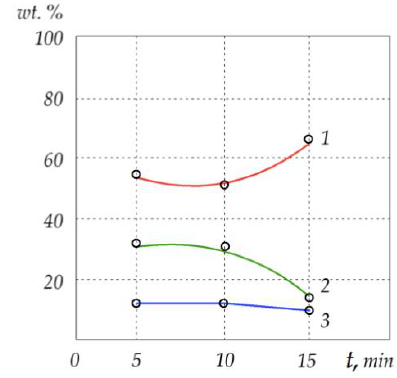
Figure 5. Percentage by weight of components in the dark phase of Cr 2 O 3 + (Cr,Al) 2 O 3 + 22 wt.% Cr cermet samples sintered at T = 1300 ◦ C under P = 30 MPA for different lengths of time t . The curves are marked as follows: 1 — chromium; 2 — aluminum; 3 — oxygen.